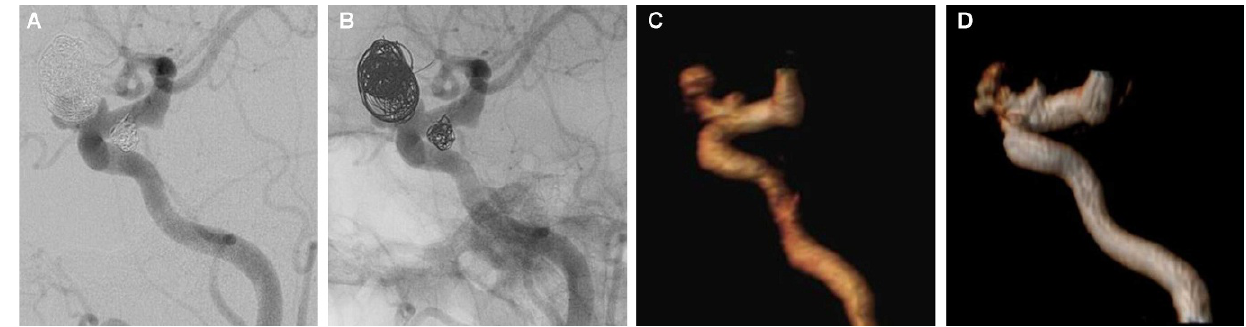
Figure 3 - An ophthalmic aneurysm with an aneurismal remnant (class III), assuming a ‘‘helmet’’ type recanalization. A: DSA demonstrating aneurismal remnant partially superimposed by the coil mesh. B: Angiography, without subtraction, showing the coil mass surrounding the aneurism recanalization. C: CE-MRA with volume-rendered reconstruction showing the aneurysm remnant without interposition of the coil mesh. D: TOF-MRA with volume-rendered reconstruction showing the aneurysm remnant without interposition of the coil mesh but with slight loss of signal in comparison to CE-MRA.